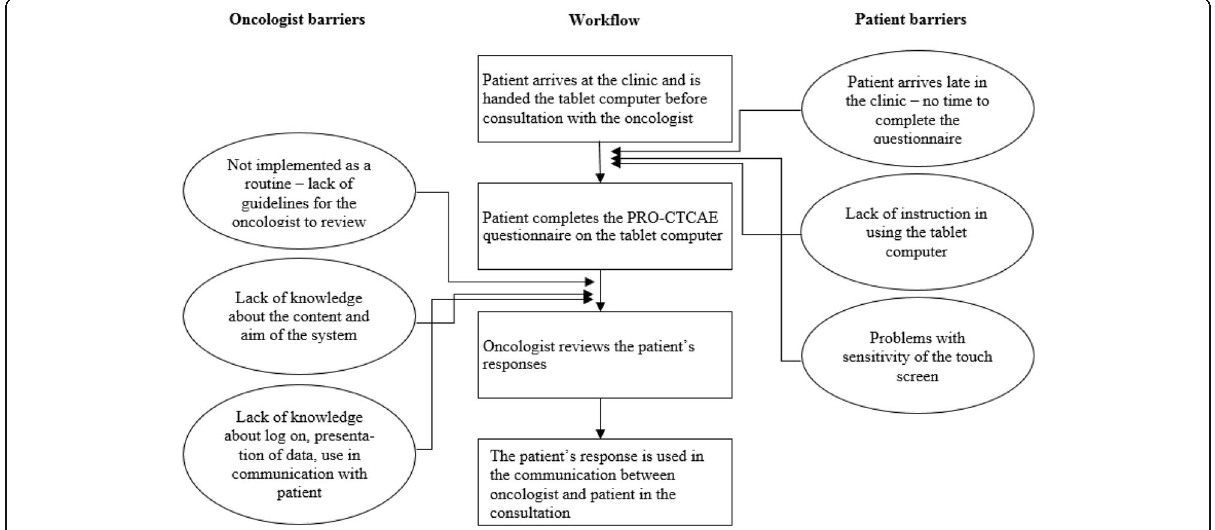
Fig. 3 Workflow and barriers for oncologists and patients in using electronic patient reporting of symptomatic